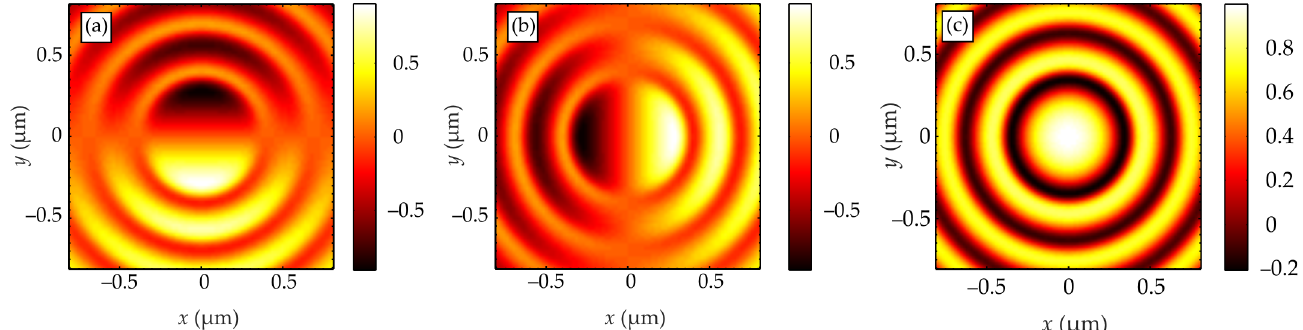
Figure 7. Distribution of the three components of the normalized Stokes vector S 1 ( a ), S 2 ( b ), S 3 ( c ) in the focal plane when focusing light with an aplanatic lens with NA = 0.95.